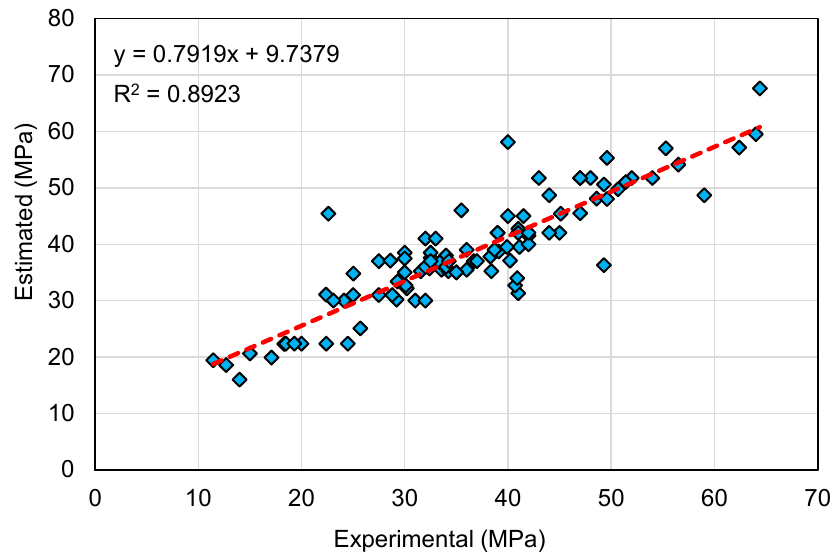
Figure 12. Relationship between experimental and estimated results for the AdaBoost regressor model.